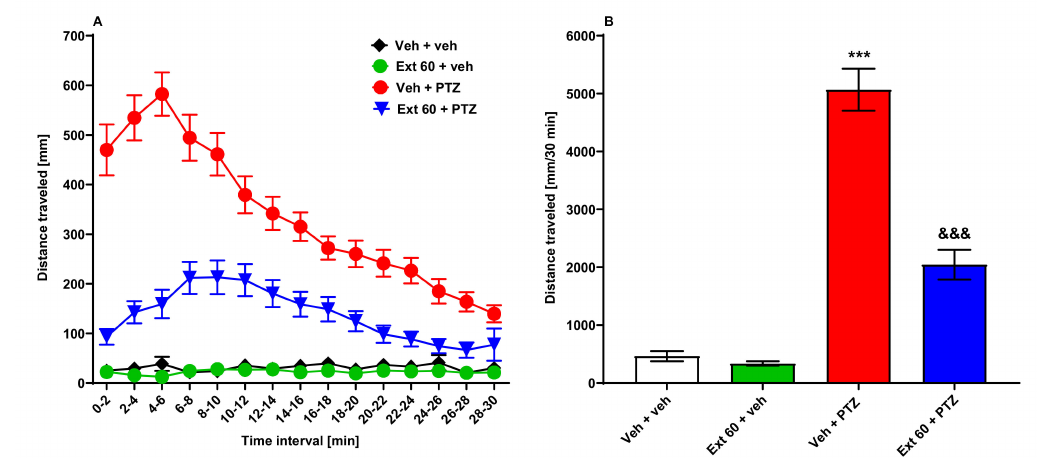
Figure 1. The influence of Zingiber officinale rhizoma methanolic extract on seizure-like behavior in the PTZ-induced hyperlocomotion assay in zebrafish. After 24 h incubation in Zingiber officinale rhizoma methanolic extract (60 µ g/mL), 7-day-old zebrafish larvae were exposed to an acute dose of PTZ (20 mM). Larval behavior was assessed 5 min after PTZ application. Results of the experiment are depicted as: ( A ) distance covered by larvae in 2 min long time bins, and ( B ) total distance covered by larvae during 30 min of the assay. Data were analyzed using one-way or two-way ANOVA with repeated measures followed by Tukey’s or Bonferroni’s post hoc test, respectively. Data are depicted as a mean ± standard error of the mean (SEM). Veh + veh ( n = 31), Ext 60 + veh ( n = 24), Veh + PTZ ( n = 48), Ext 60 + PTZ ( n = 48). *** p < 0.001 vs. Veh + veh; &&& p < 0.001 vs. Veh + PTZ. Ext 60— Zingiber officinale methanolic extract (60 µ g/mL), PTZ—pentylenetetrazole, Veh—vehicle. n —refers to the total number of